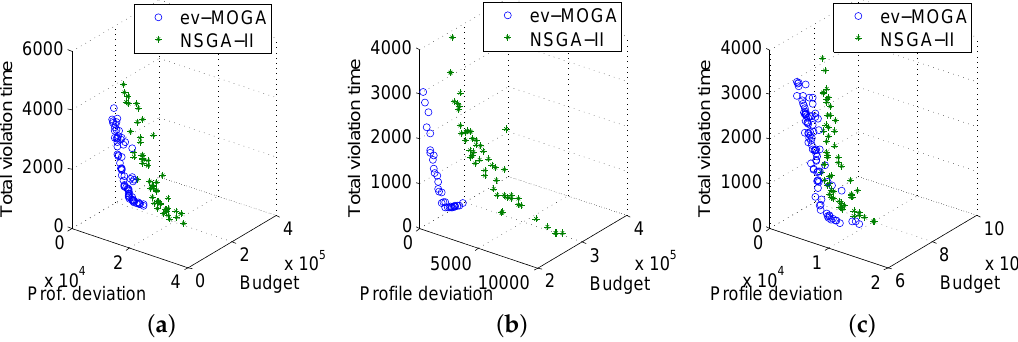
Figure 8. Best aggregated Pareto front computed by each algorithm for medium-sized workloads and for each green energy profile. ( a ) morning profile ( g 1 ); ( b ) midday profile ( g 2 ); and ( c ) night profile ( g 3